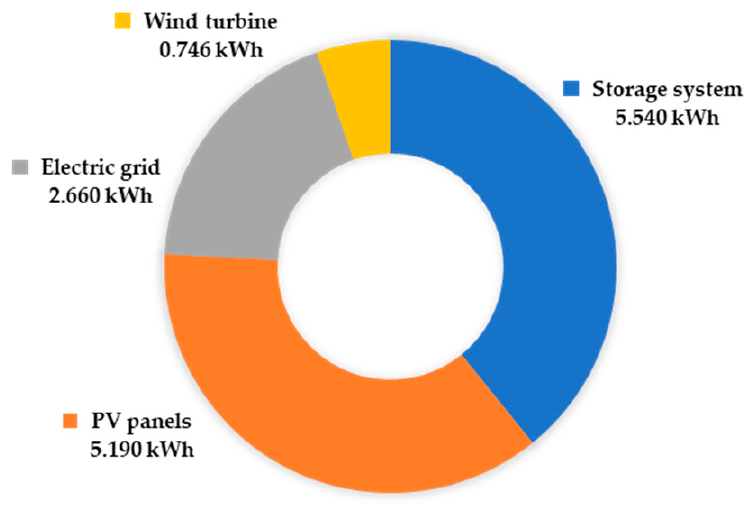
Figure 13. Distribution of electricity produced by each source. Third scenario data. Table 4. The amount of energy used for consumption—Third scenario.